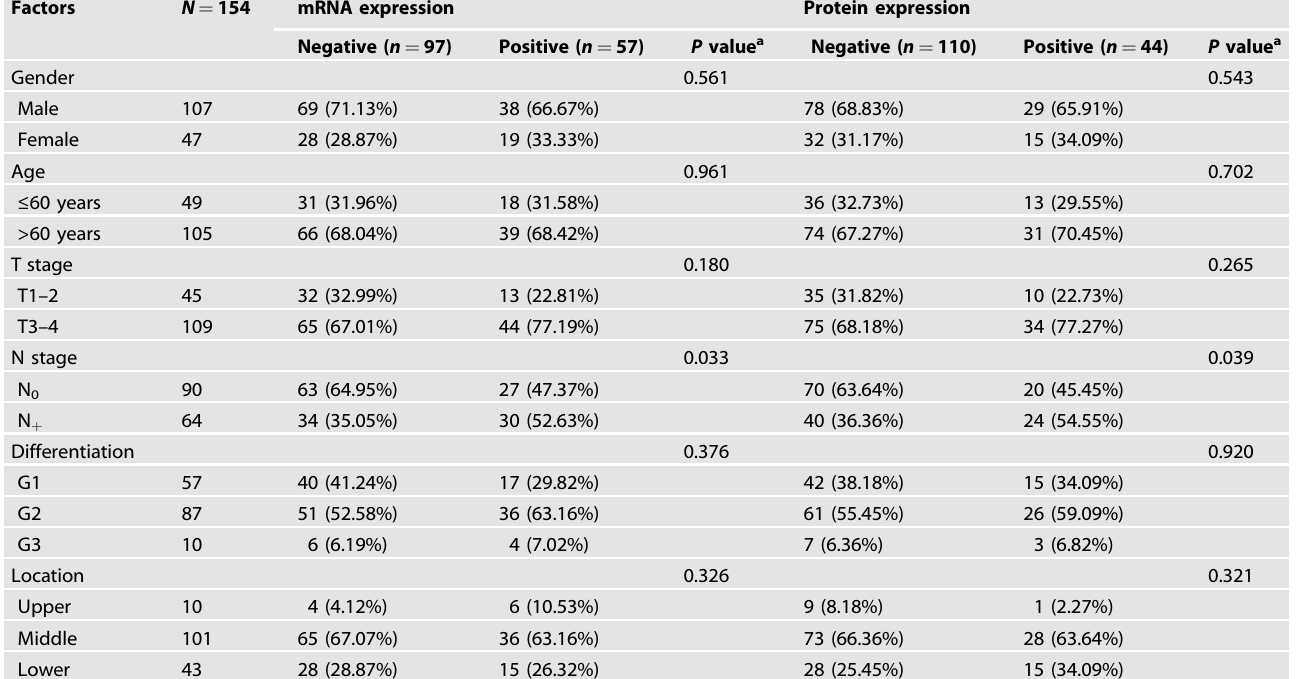
Table 2. Association between LPCAT1 expression (based on mRNA expression and protein expression) and clinicopathological